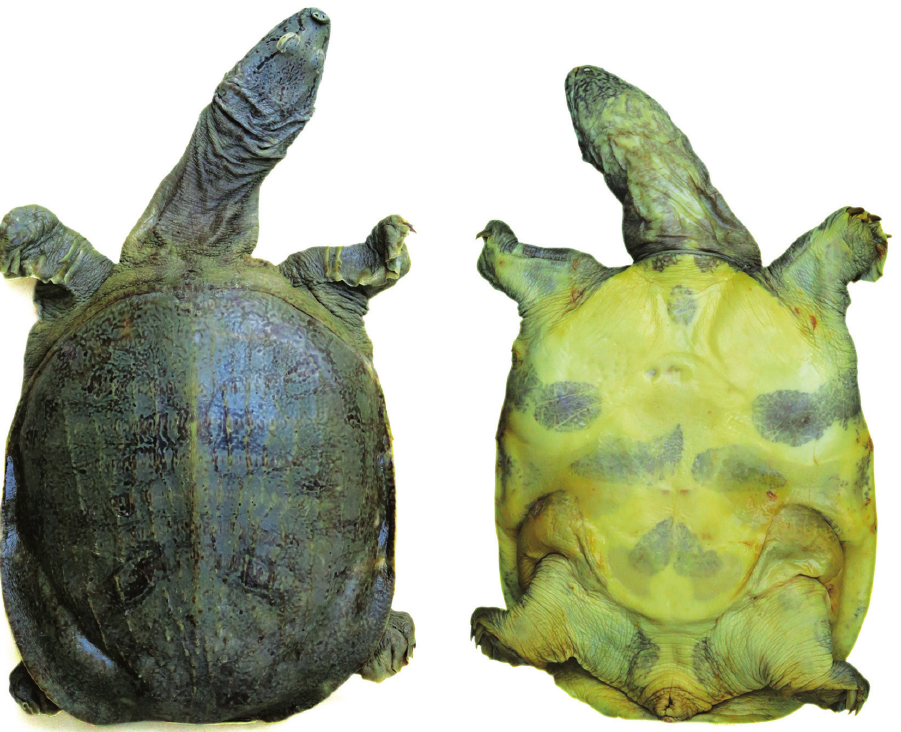
Figure 1. Dorsal and ventral aspects of the holotype of Pelodiscus variegatus sp. n. (IEBR 4480, adult female, 134.2 mm PL). Photographs Balázs Buzás. Table 1. Selection of diagnostic sites of the 12S rRNA gene for Pelodiscus species (84 wild-caught indi- viduals from Gong et al. 2018). Positions refer to the 400-bp-long reference alignment in the Supporting Information. G, H, and I are genetic lineages that represent putatively distinct taxa (Gong et al. 2018). n 13 P. variegatus sp. n.